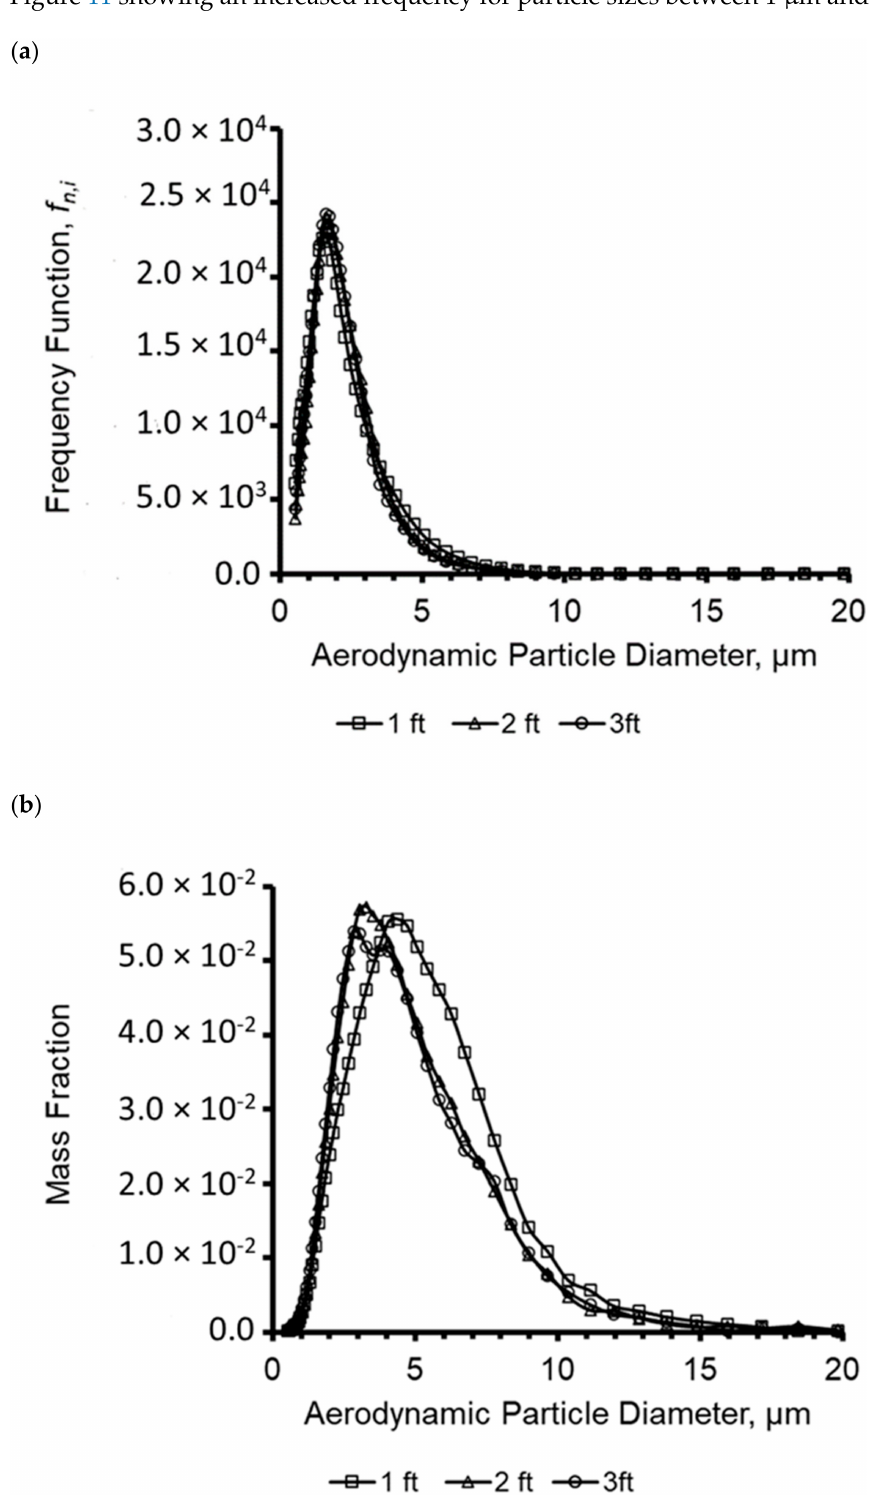
Figure 11 showing an increased frequency for particle sizes between 1 µ m and 2 µ m [37].